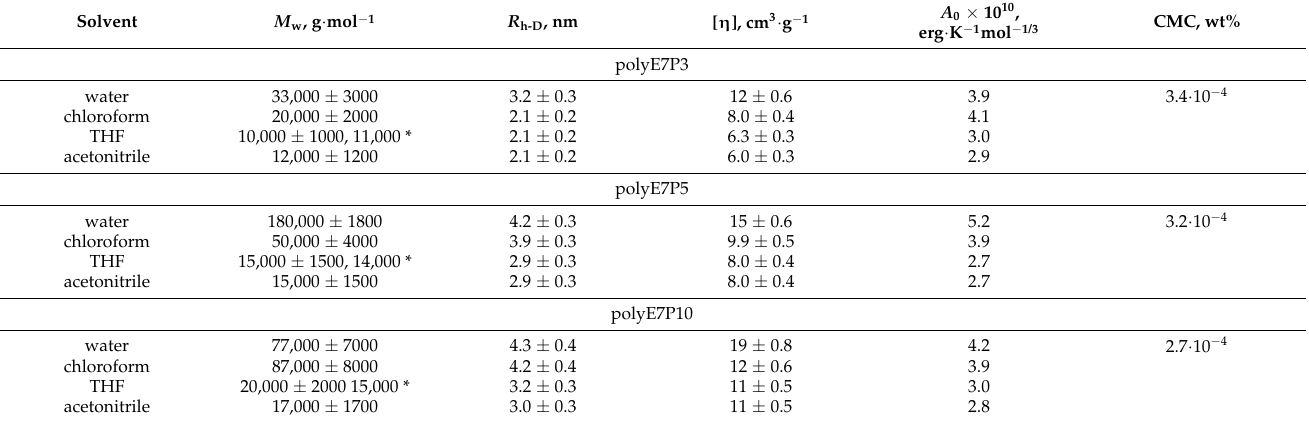
Here, I 90 is the excessive intensity of light scattered at an angle of 90 ◦ , N A is Avogadro’s number, and dn / dc is the refractive index increment. The values of dn / dc were determined using an RA-620 refractometer (KEM, Kyoto, Japan) with a wavelength λ 0 = 589.3 nm. The values of dn / dc were calculated from the slope of concentration dependences of the difference ∆ n = n − n 0 between the refractive indexes of the solution n and the solvent n 0 . The Debye plots for the investigated solutions are shown in Figure S4 (Supplementary Materials). Note that acetonitrile was thermodynamically good for all polymer samples (the second virial coefficient was positive). The values M w and R h-D are shown in Table 1. Table 1. The molar masses, hydrodynamic characteristics, and CMC of